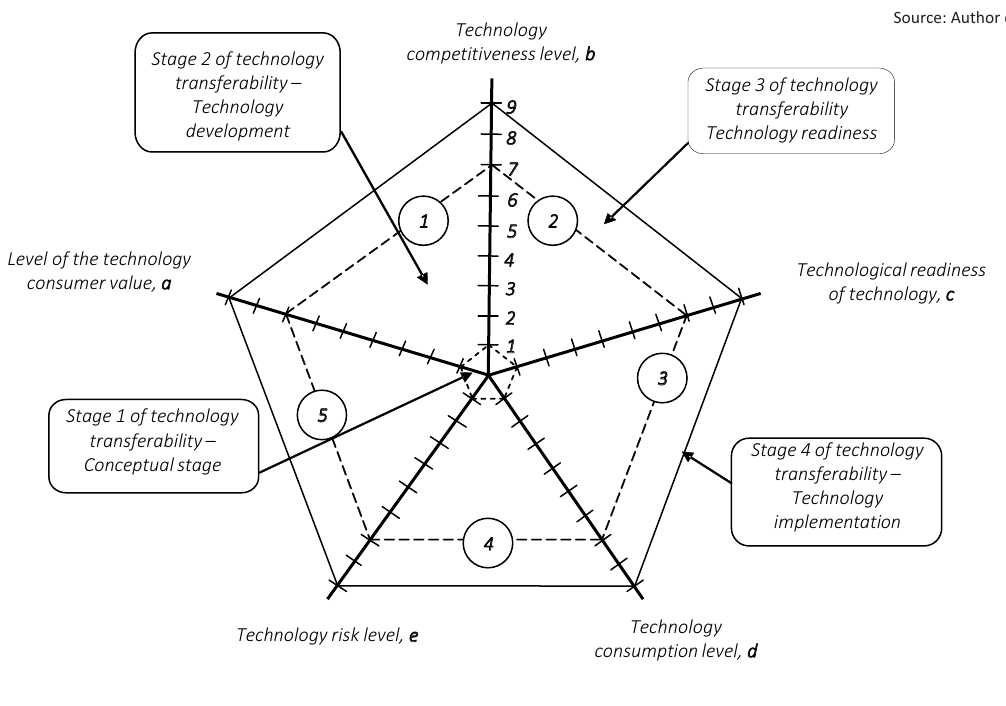
Legend: 1 – the numbering of triangles that form a Figure 1. Determining the polygon for the level of technology transferability